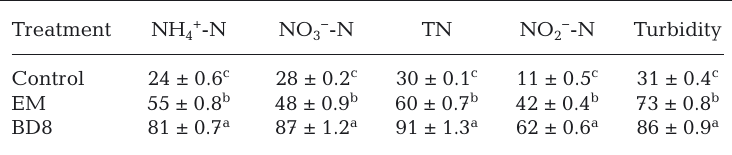
Table 4. In situ aquaculture pond water purification, reported as the removal (%) of nitrogenous pollutants on Day 25 (mean ± SD). EM: commercial aqua- culture water purification agent; BD8: inoculation levels of Bacillus subtilis D9 at 5.5 × 10 8 cfu ml −1 . Within columns, means with the same superscript letters are not significantly different (Tukey’s post hoc test, p >